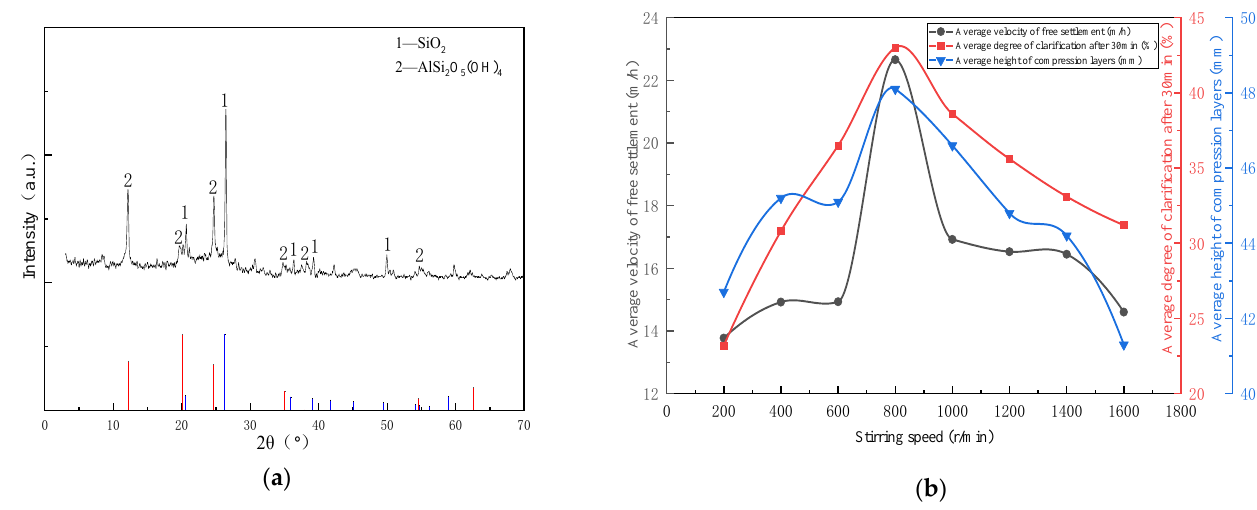
Figure 5. ( a ) Analysis of mineral composition of coal sample; ( b ) Flocculation determination of main parameters versus stirring speed (18 million molecular weight APAM). Table 3. Performance test results of 18 million molecular weight APAM under optimal solution.